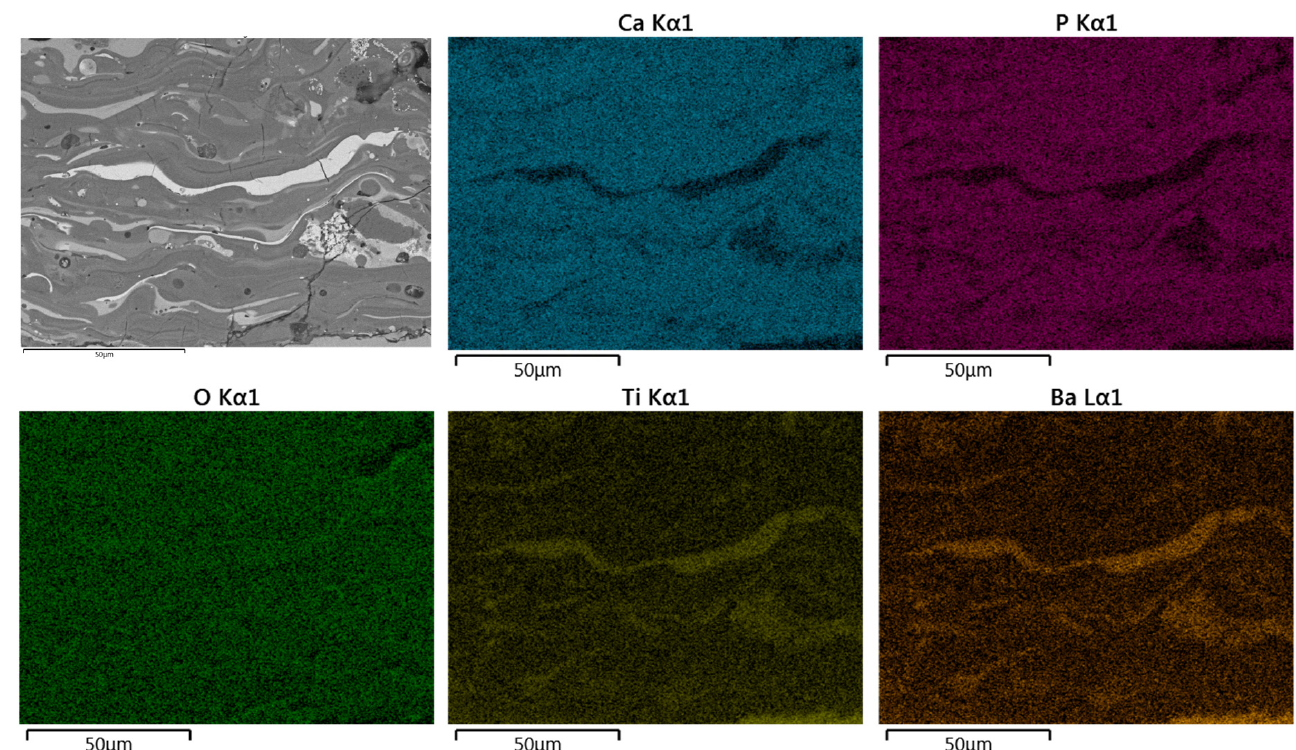
Figure 10. Typical SEM-BSE image in cross-section and corresponding EDS elemental mapping of Ca, P, O, Ti, and Ba of HA30BT coating performed with HEBM powders.